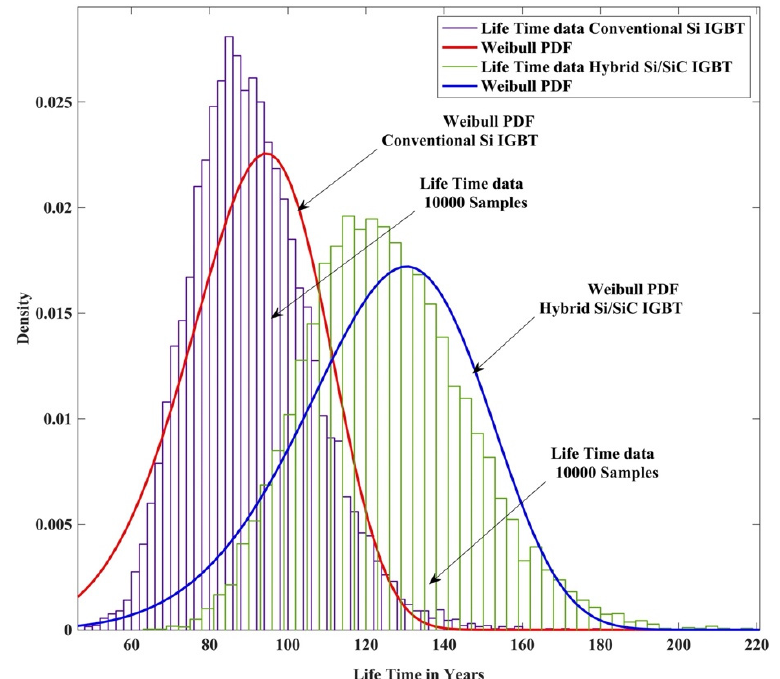
Figure 14. Lifetime distribution.